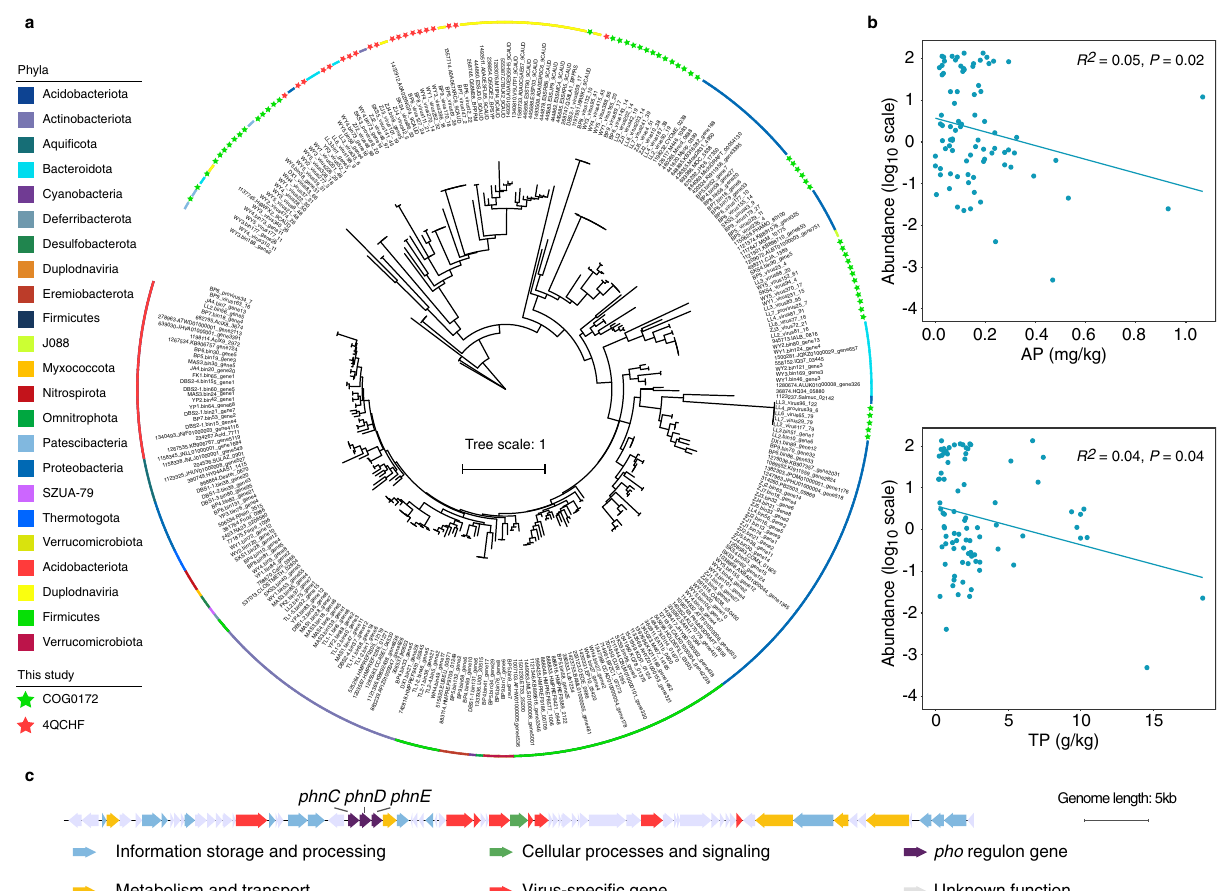
Fig. 6 Genomic analyses of viral phosphorus (P) metabolism-related genes. a Maximum-likelihood phylogenetic tree with phoH genes from the AMD sediments (indicated by stars) compared to homologs found in eggNOG v5.0.0 database and the host proteins colored by different phyla (the outer